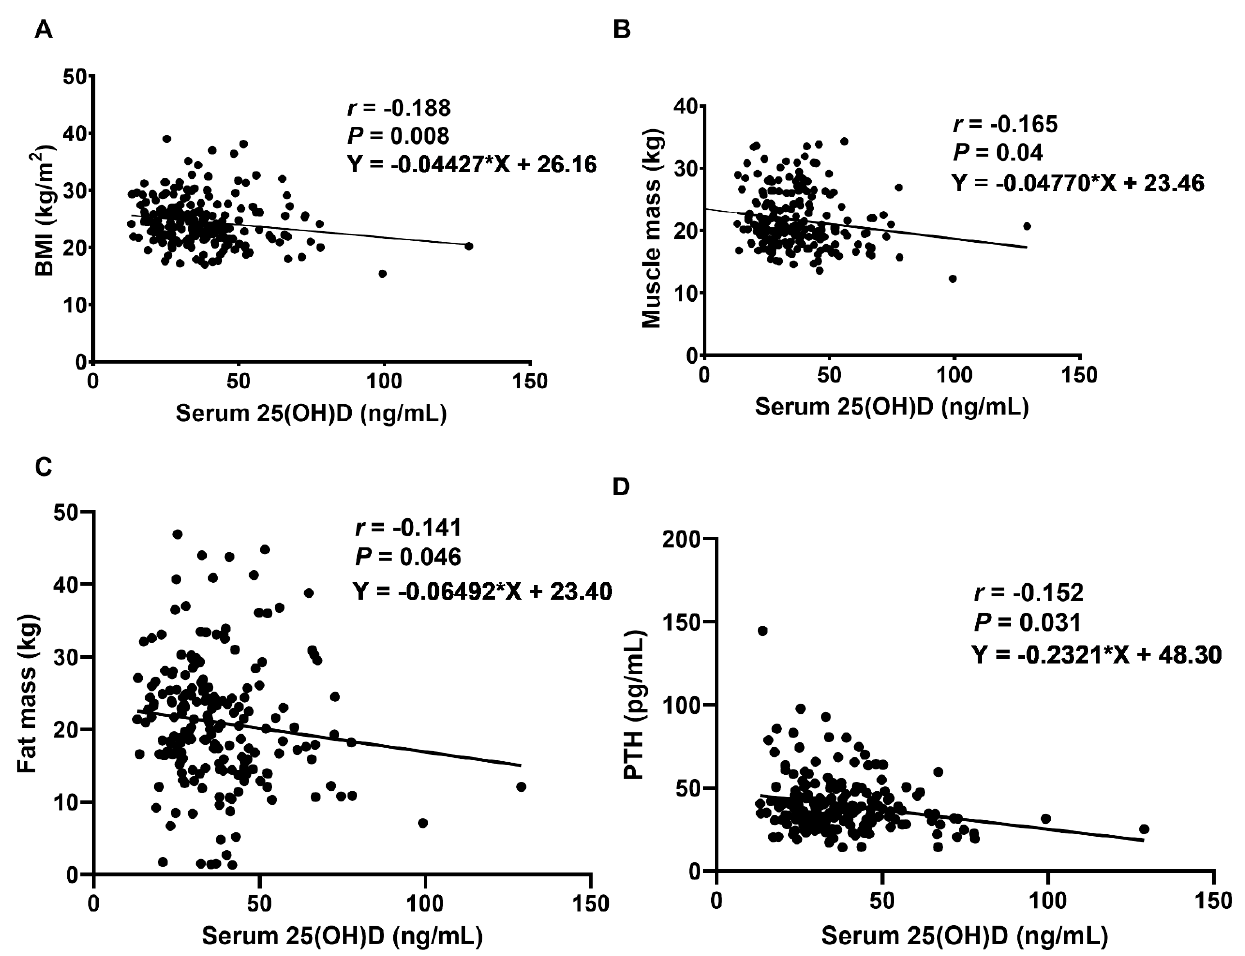
Figure 1. Correlations between serum 25(OH)D concentration and ( A ) BMI, ( B ) muscle mass, ( C ) fat mass, and ( D ) PTH levels in LDD patients. r : Spearman’s coefficient, statistically significant at p < 0.05. Table 2. Correlations between serum 25(OH)D and different parameters (n = 200).